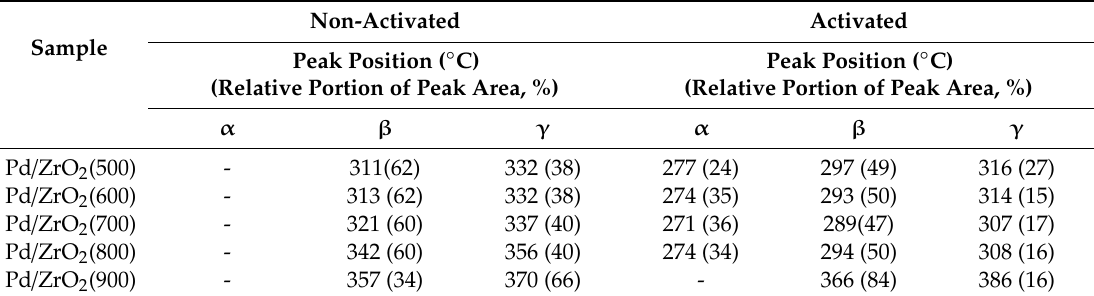
Table 3. Reduction temperature and relative portion of peak area obtained from the CH 4 -TPR measurement over the non-activated and activated Pd / ZrO 2 (x)